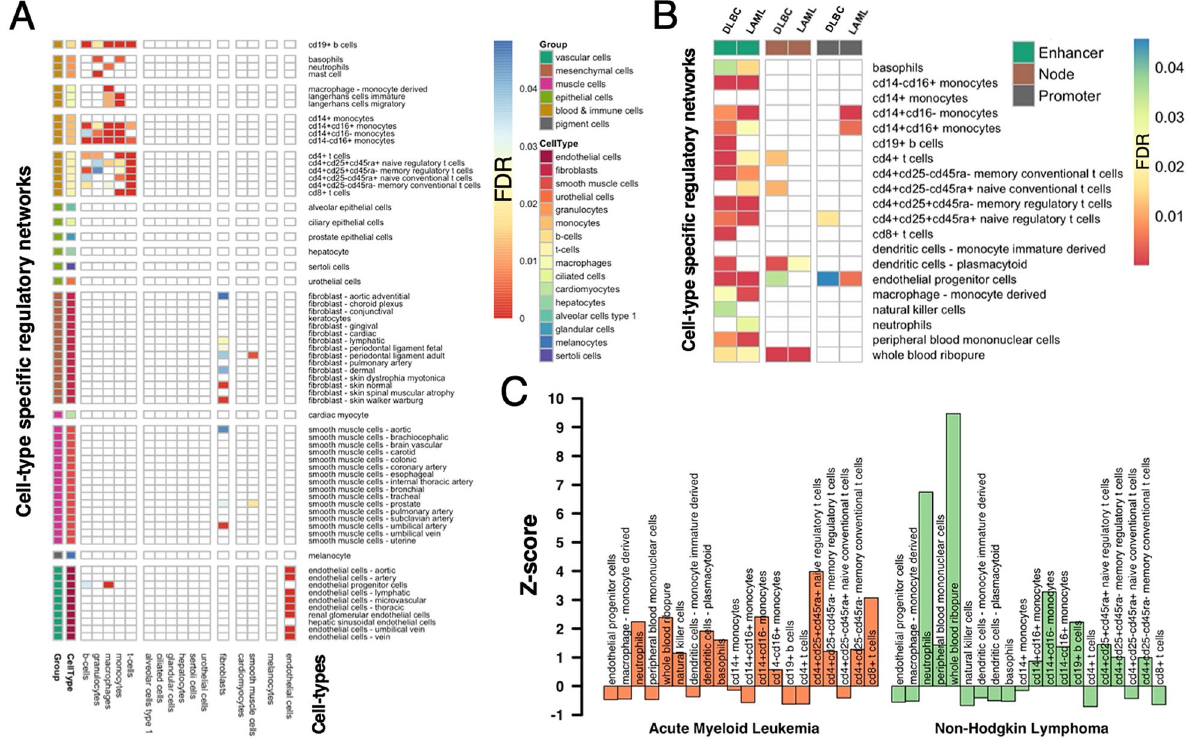
Figure 5. Tissue and cancer specificity of target genes regulated by indispensable enhancer-binding TFs in cell- type specific regulatory networks. In ( A ) we determined the enrichment of cell-type specifically expressed genes in sets of target genes of indispensable enhancer-binding TFs in the corresponding regulatory cell-type network (FDR < 0.05, Fisher’s exact test). We observed that such target genes were enriched with genes expressed in blood and immune-related cell types and endothelial cell types. ( B ) We corroborated our findings by observing the enrichment of genes associated with blood-related cancers such as Acute Myeloid Leukemia (LAML) and Lymphoid Neoplasm Diffuse Large B-cell Lymphoma (DLBC) in sets of target genes of indispensable enhancer- binding TFs in cell-type networks of blood and immune cell. ( C ) Determining the enrichment of gene targets of drugs approved for Acute Myeloid Leukemia and Non-Hodgkin Lymphoma, we found an enrichment in sets of target genes of indispensable enhancer-binding TFs in the cell-type networks of blood and immune